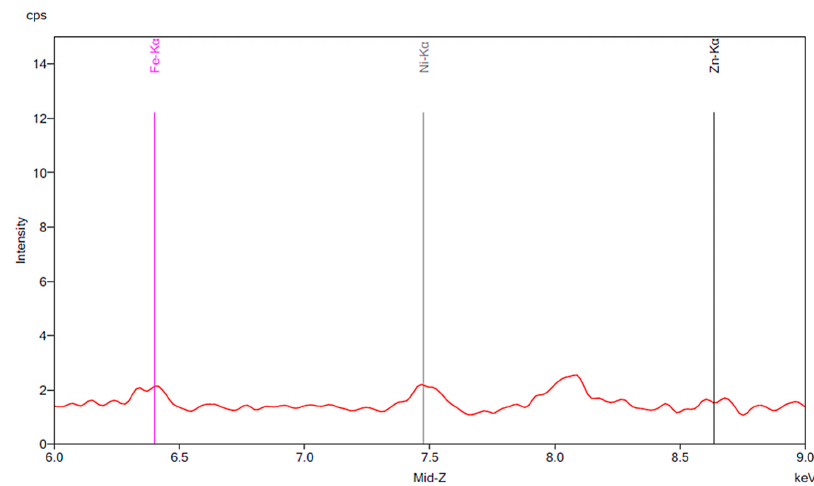
Figure 12. The results of the tooth brushing experiment for artificial teeth exposed to cola. The red peaks indicate new artificial teeth. The green peaks represent the artificial teeth after 24 h exposure to cola. The blue peaks correspond to the cola exposed tooth following 30 s of brushing.